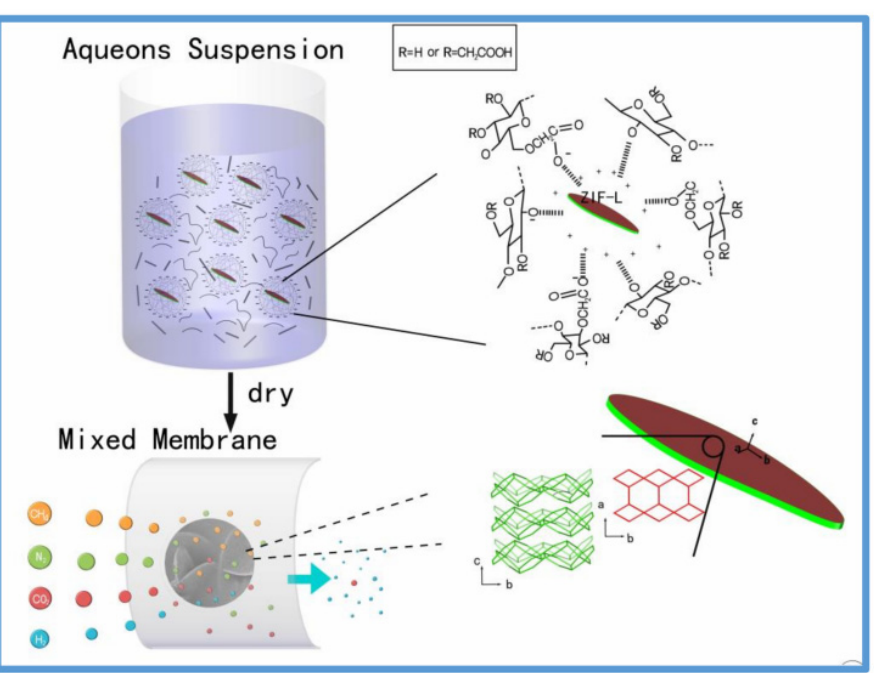
Figure 9. Fabrication of CMC-ZIF-L nanoporous composite membrane for gas separation applica- tions [166].